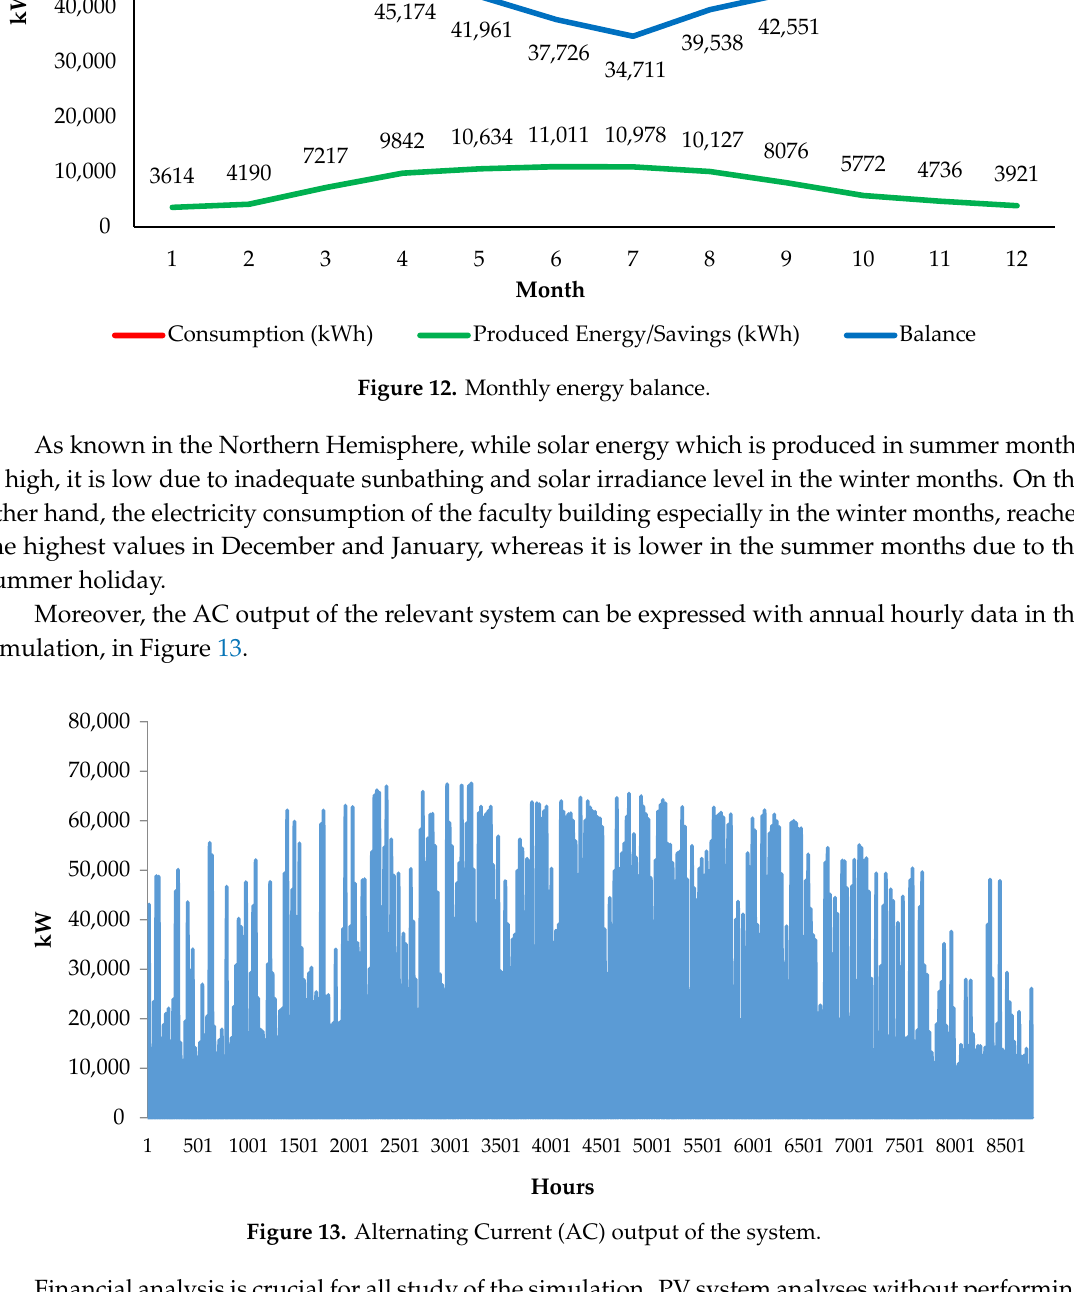
Figure 13. Alternating Current ( AC) output of the system.